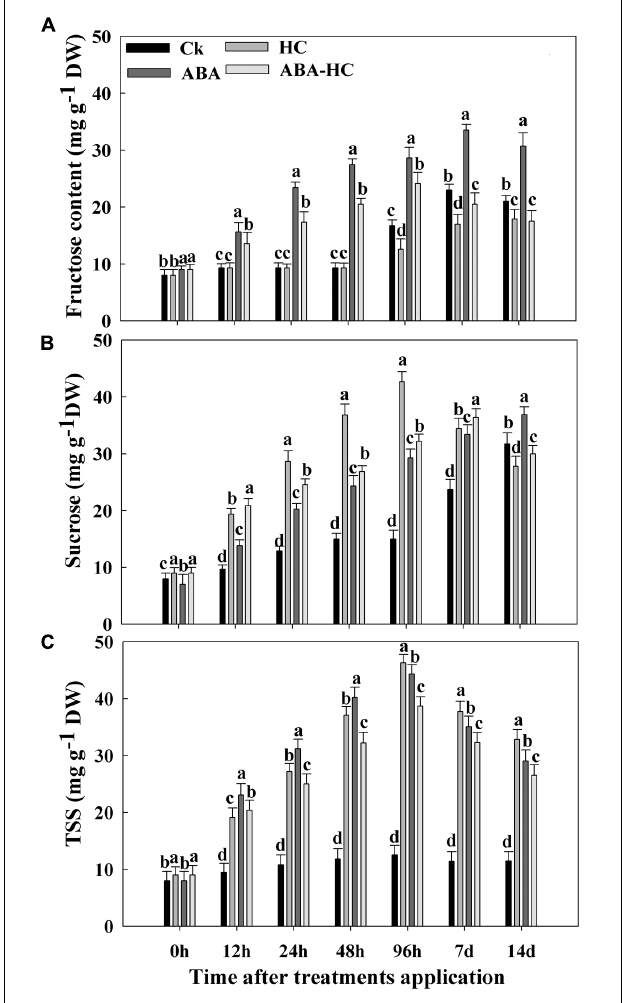
FIGURE 4 | Changes in carbohydrate (A) Fructose, (B) Sucrose, and (C) TSS concentration in the buds of cv. ‘Shine Muscat’ treated with HC, ABA and AB-HC or control and sampled at 0, 12, 24, 48, 96 h, 7 and 14 days after treatement. Verticle lines above the means bars indicate standard error ( n = 3; p = 0.05) using Tukey’s HSD post hoc test. a–d represents significant difference between treatments.